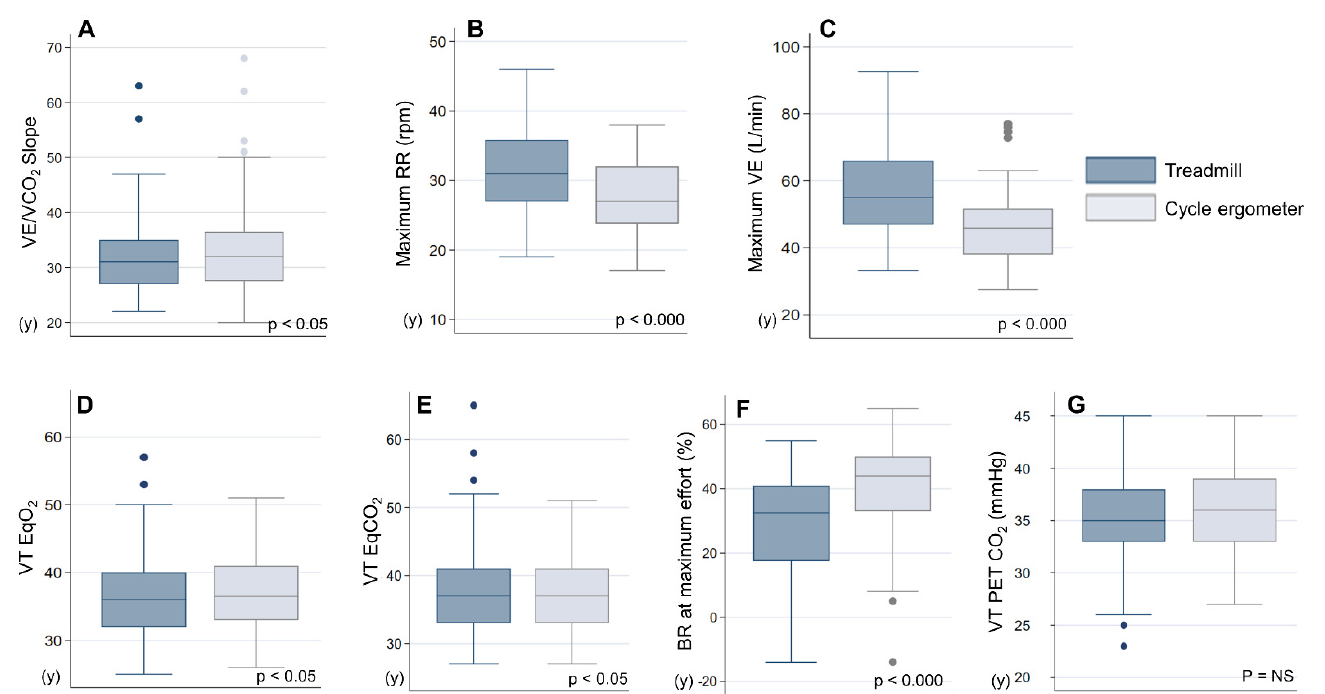
Figure 3. Boxplot of respiratory variables on the treadmill and cycle ergometer. ( A ) VE/VCO 2 Slope, ( B ) maximum RR (rpm), ( C ) maximum VE (L/min), ( D ) VT Eq O 2 , ( E ) VT Eq CO 2 , ( F ) BR at maximum effort (%), ( G ) VT PET CO 2 (mmHg). RR: respiratory rate; VE: ventilation; VT: ventilatory threshold; EqO 2: oxygen equivalent; EqCO 2 : carbon dioxide equivalent; BR: breathing reserve; P ET CO 2 : partial pressure end-tidal carbon dioxide; NS: not significant.